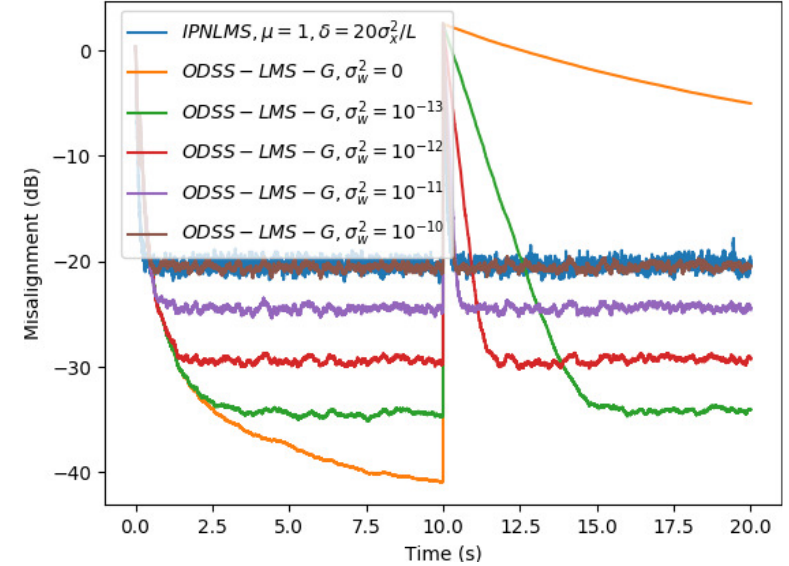
Figure 3. Normalized misalignment of the IPNLMS and ODSS-LMS-G algorithms for different values of σ 2 w . Echo path changes at time 10 s. The input signal is a white Gaussian noise, L = 512, and SNR = 20 dB. The unknown system is the acoustic echo